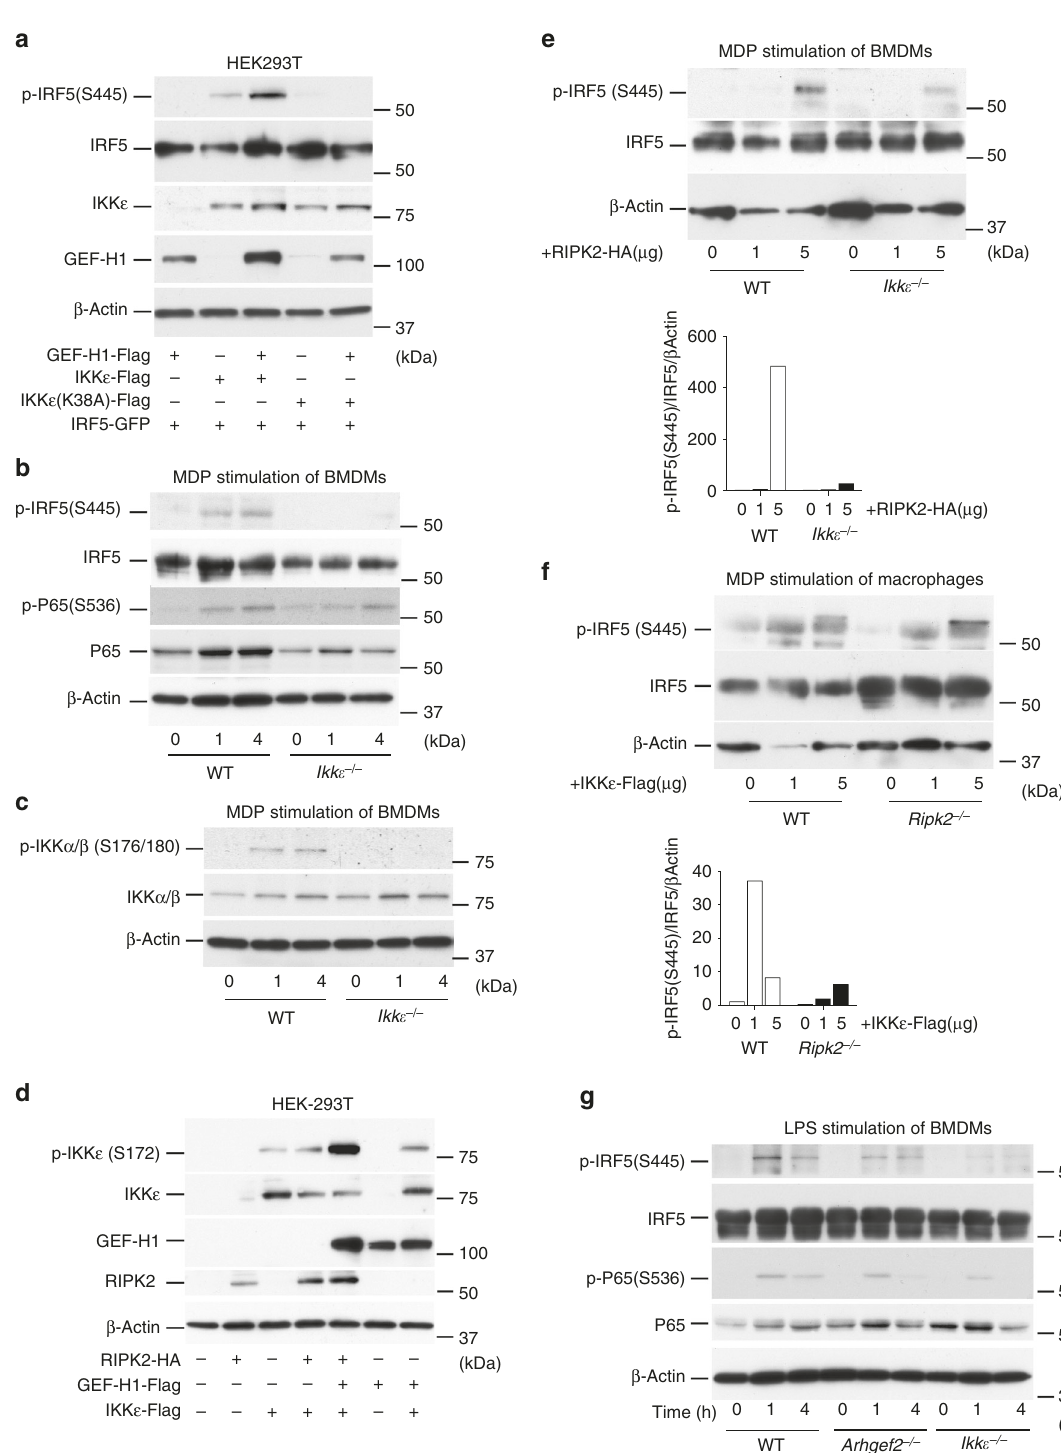
Fig. 2 IKK ε is required for the phosphorylation of IRF5. a Assessment of IRF5 phosphorylation in the absence or presence of GEF-H1, IKK ε , or a kinase de fi cient IKK ε (K38A) variant in HEK293T cells. b Immunoblot analysis of IRF5 and NF- κ B-p65 phosphorylation in BMDMs from WT and Ι kk ε − / − mice after stimulation with N -glycolyl-MDP for 1 h and 4 h. c Western blot analysis of IKK α / β phosphorylation in BMDMs from WT and Ι kk ε − / − mice after stimulation with N -glycolyl-MDP for 1 h and 4 h. d Immunoblot analysis of IKK ε phosphorylation mediated by GEF-H1 and/or RIPK2 after co-expression in HEK293T cells. e Immunoblot analysis of IRF5 phosphorylation in response to RIPK2 overexpression in WT and Ikk ε − / − BMDMs with band intensities quanti fi ed using densitometry and Image J software. f Western blot analysis of IRF5 phosphorylation in response to overexpression of IKK ε in WT or Ripk2 − / − macrophages with band intensities quanti fi ed using densitometry and Image J software. g Assessment of expression and phosphorylation of IRF5 and NF- κ B-p65 in BMDMs from WT, Arhgef2 − / − , and Ι kk ε − / − mice after exposure to LPS (100 ng ml − 1 ) for 1 h and 4 h. Source data are provided as